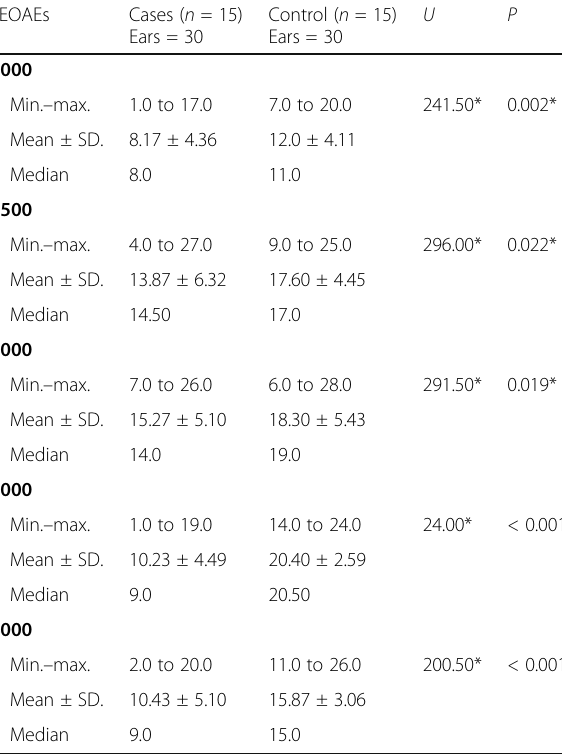
Table 3 Comparison between the two studied groups according to suppression value in DPOAE amplitudes (dB SPL) Suppression value Cases ( n = 15) Ears = 30